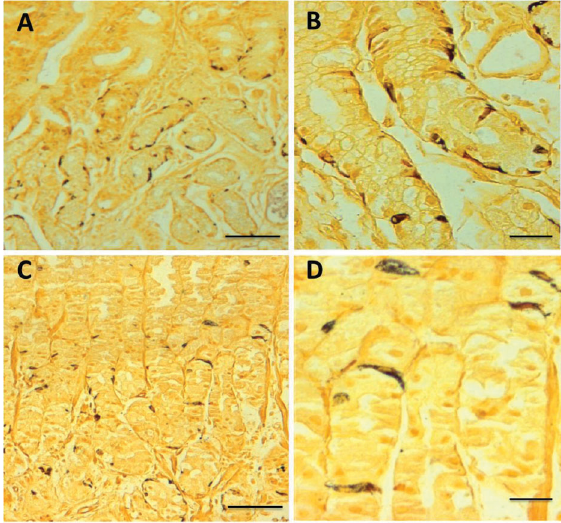
Figure 1. Argyrophil cells stained by the Grimelius technique in the antropyloric ( A and B ) and oxyntic gastric mucosa ( C and D ) of morbidly obese patient without metabolic syndrome. Bars: 50 m m ( A and C ), and 10 m m ( B and D